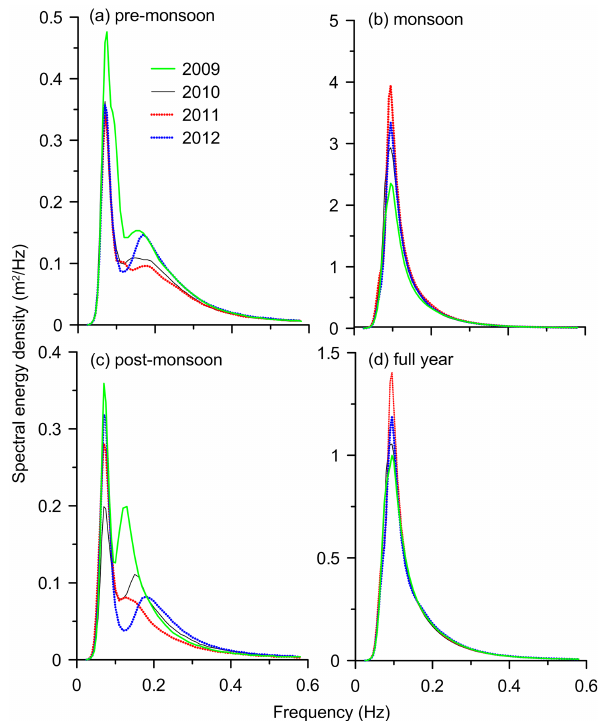
Figure 8. Wave spectra averaged over (a) pre-monsoon, (b) mon- soon, (c) post-monsoon and (d) full year, for different years.